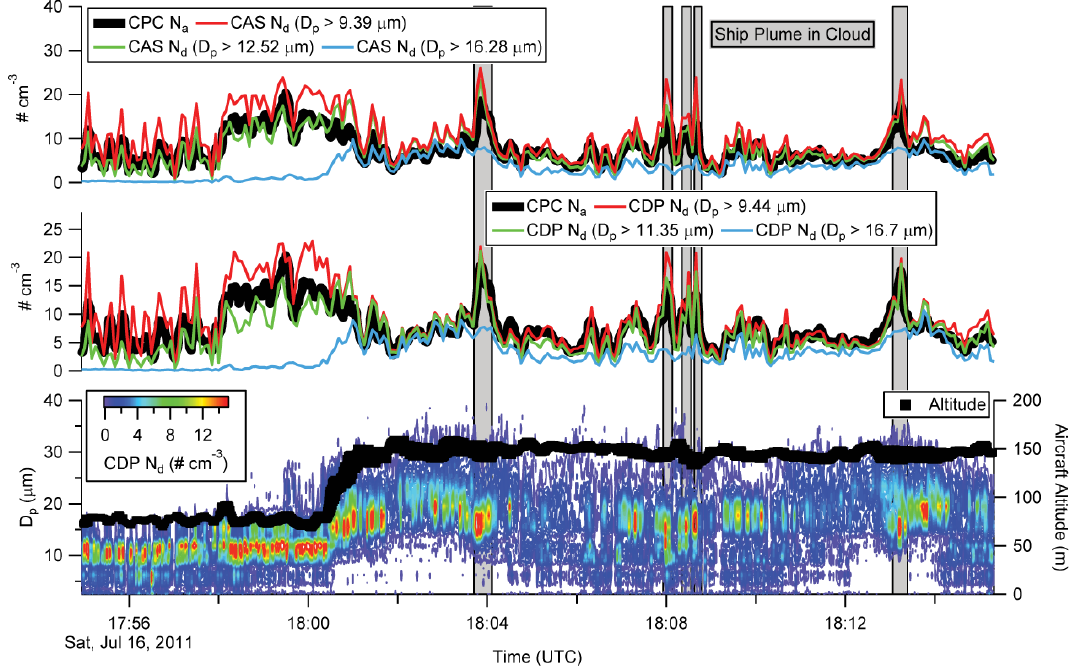
Fig. 8. Time series of aircraft data collected during Flight 6 of the 2011 E-PEACE campaign on 16 July 2011. The 20-min time segment coincides with when the Twin Otter was flying in a stratocumulus cloud deck of the coast of Monterey, California. This flight was coor- dinated with the R/V Point Sur , which generated smoke that influenced the cloud in the several gray shaded regions of the time series via enhancements in drop concentration and reductions in drop size. The total particle concentration ( N a ) measured behind the CVI by a CPC (with enhancement factor, ∼ 3.3, applied) is compared to total cloud drop concentration ( N d ) measured by two independent probes, where N d is integrated above three different diameters to further constrain the CVI cut size diameter. Size-dependent transmission efficiency losses from Fig. 4 are applied to the N d data. The aircraft altitude marker size is proportional to LWC (range ∼ 0.05–0.30gm − 3 )